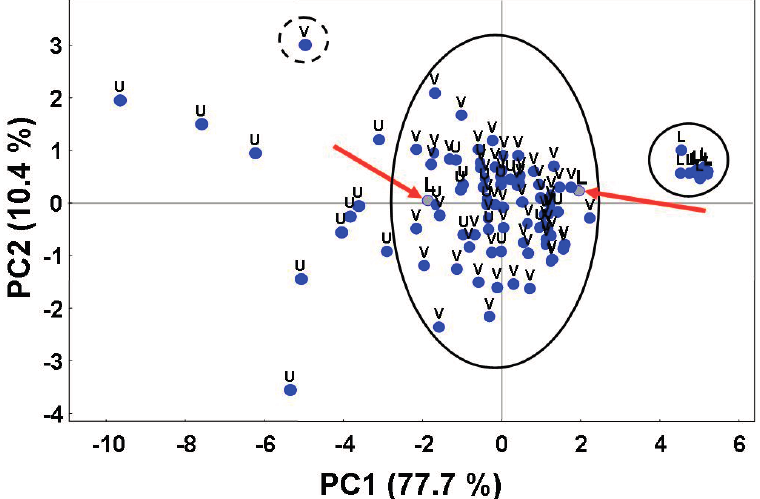
Figure 11. Distribution of samples in the reduced bi-dimensional factor space given by the first and second principal components (PC1 and PC2, respectively). The partial overlap of clusters for samples belonging to the U class with that for samples belonging to the V class is highlighted by the black ellipse. The arrows indicate possible outliers. The doubtful case is highlighted with a dotted circle.